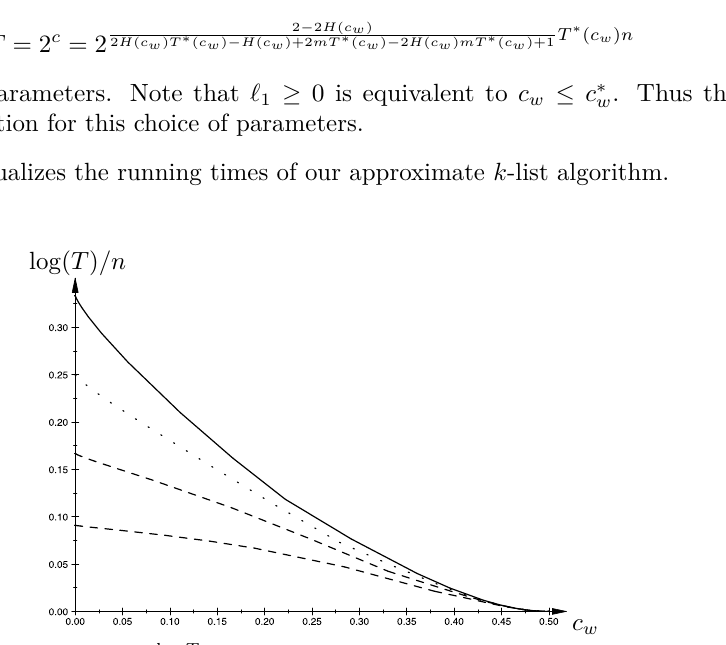
Figure 5: run-time exponent log T of the approximate k -list algorithm for k = 4 (solid), n k = 8 (dotted), k = 32 (dashed, upper), k = 1024 (dashed,